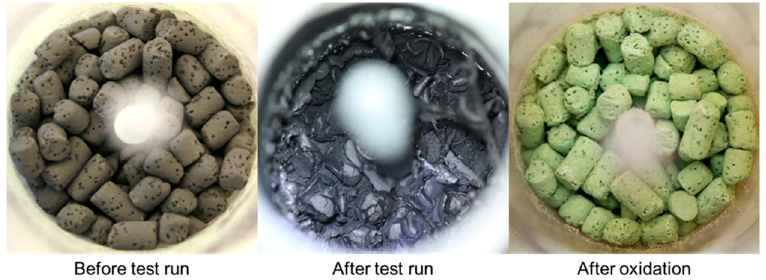
Figure 11. In-house nickel catalyst before test run 28, after a test run with carbon accumulation, and after oxidation. Reaction conditions: atmospheric pressure, 24,500 vol-ppm ethylene, 950 °C, TOS 96 h and gas composition 2. The catalyst particles are fully intact after the oxidation, which indicates that no whisker carbon was formed.